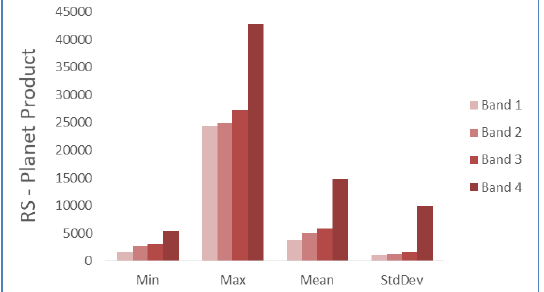
Gráfico 2 : Planet Product SR (Sum of